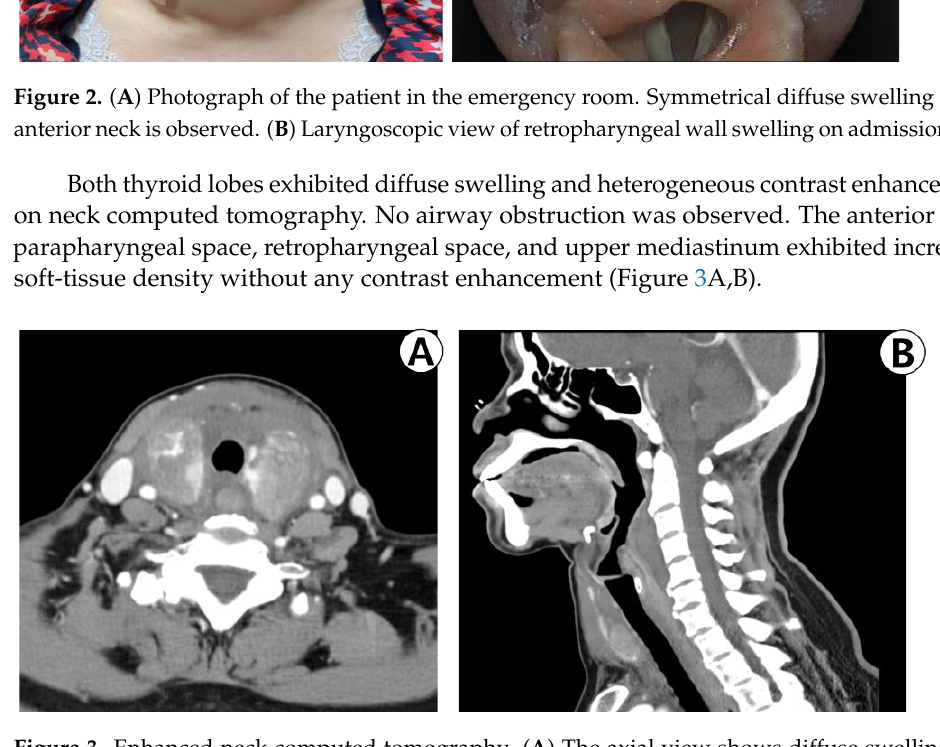
Figure 3. Enhanced neck computed tomography. ( A ) The axial view shows diffuse swelling and heterogenous enhancement of both thyroid lobes. ( B ) The sagittal view shows diffuse non-enhancing soft-tissue density lesions of the retropharyngeal space and superior mediastinum.